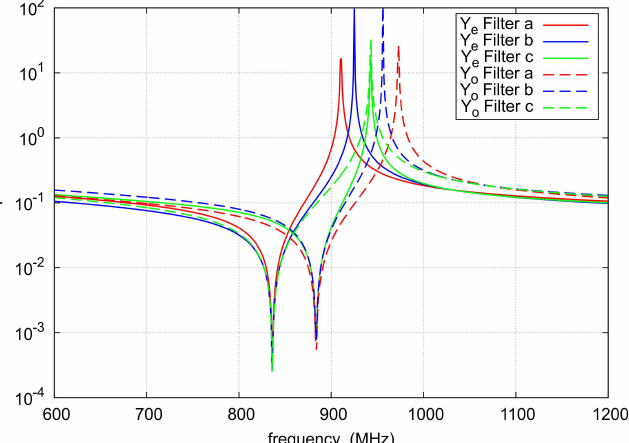
Figure 3. Frequency behaviour of the Y e and Y o admittances of the double-tuned coupled resonator filter versions presented in Figure